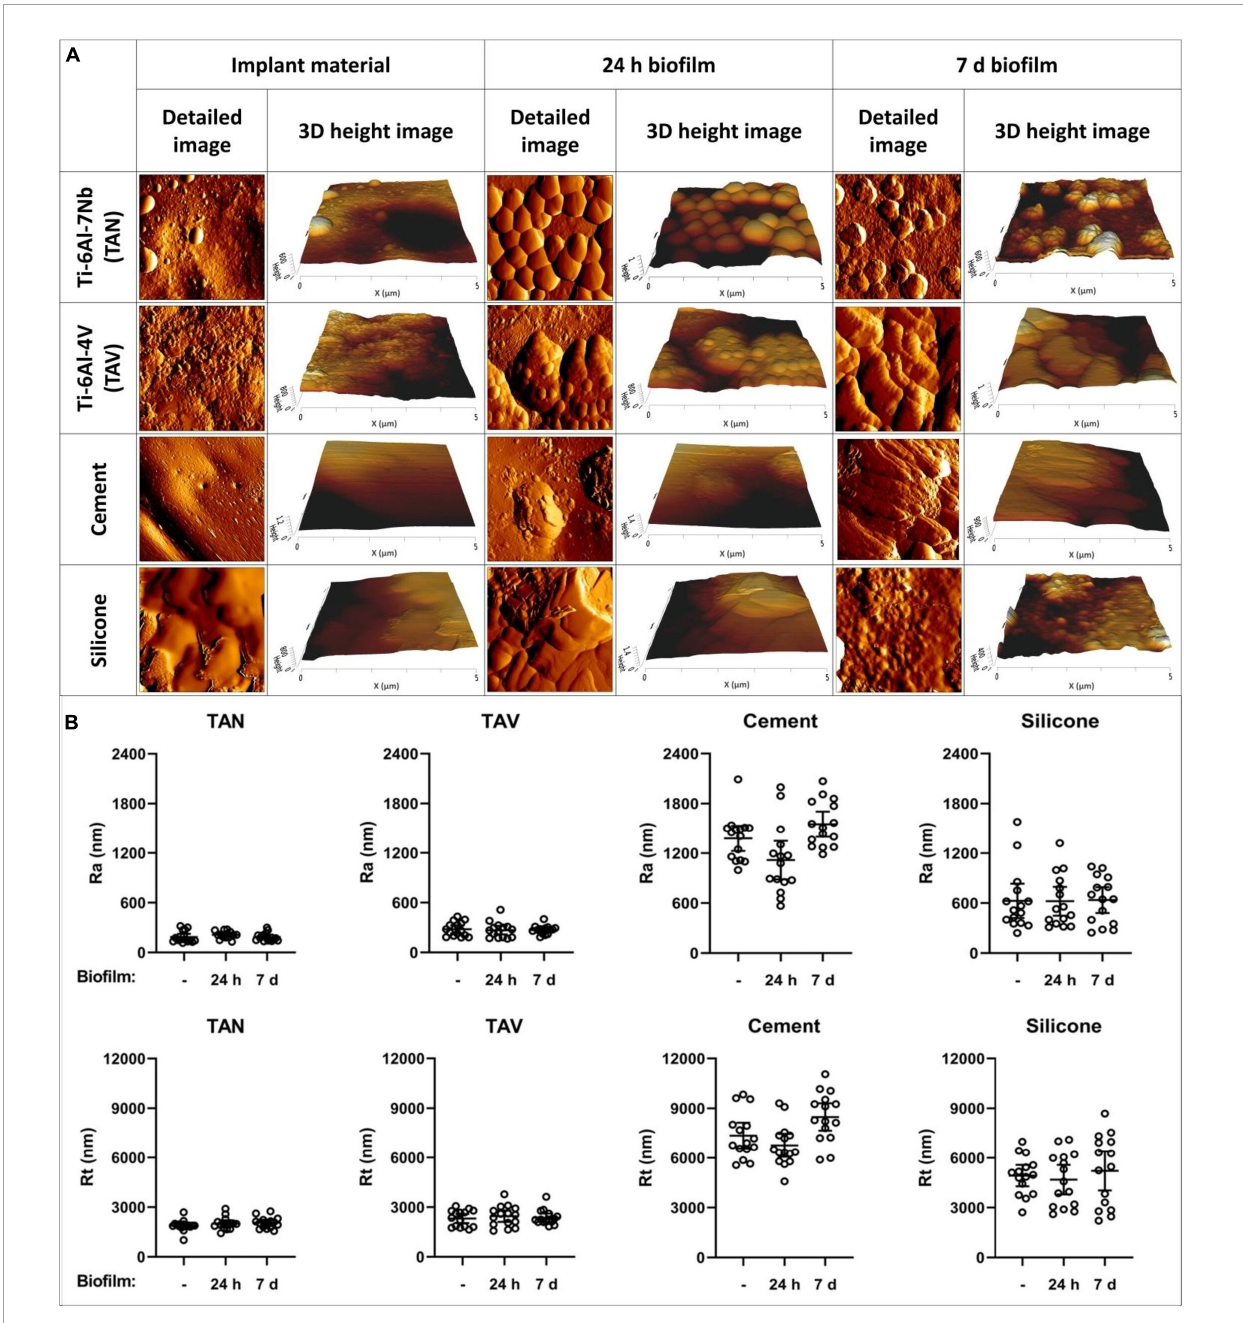
FIGURE2 Atomic force microscopy images of various implant materials. (A) At different timepoints: at baseline without bacteria, with 24-h biofilm and with 7-day biofilm. Per material and per timepoint a detailed 5 µ m × 5 µ m image and a 3D height image are shown. (B) Surface parameters of the implant materials Ti-6Al-7Nb (TAN) Ti-6Al-4V (TAV), orthopedic bone cement and silicone. On the y -axis, the surface roughness Ra and peak-to-valley roughness Rt are shown. On the x -axis, the following biofilm timepoints are shown:–(no biofilm); 24 h biofilm; 7 days biofilm. Each datapoint represents one disk (3 disks; 5 areas each; N = 15). Horizontal lines indicate the means and error bars indicate 95% confidence